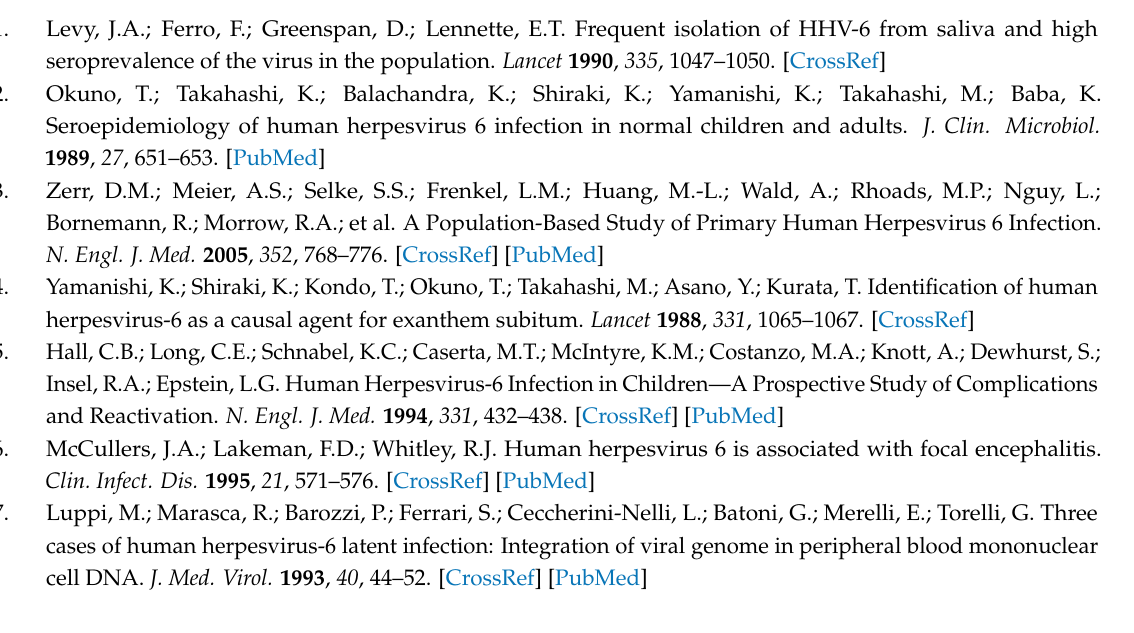
Figure S1: Effect of HHV-6 infection on the ND10 complex. Figure S2: Schematic image describes the construction of HHV-6A-U57-p2A-GFP BAC upon en passant